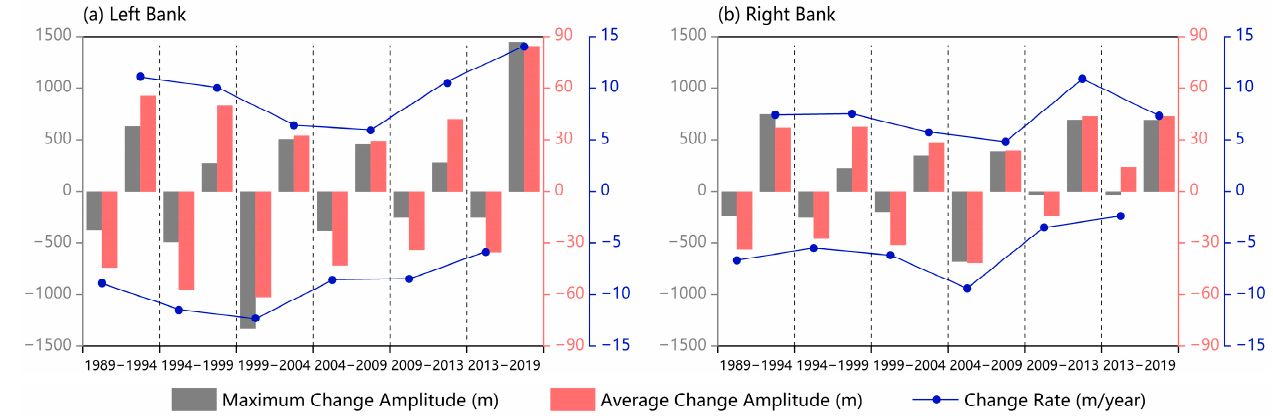
Figure 11. Change rates of the left and right banks from 1989 to 2019. ( a ): Left Bank; ( b ): Right Bank.